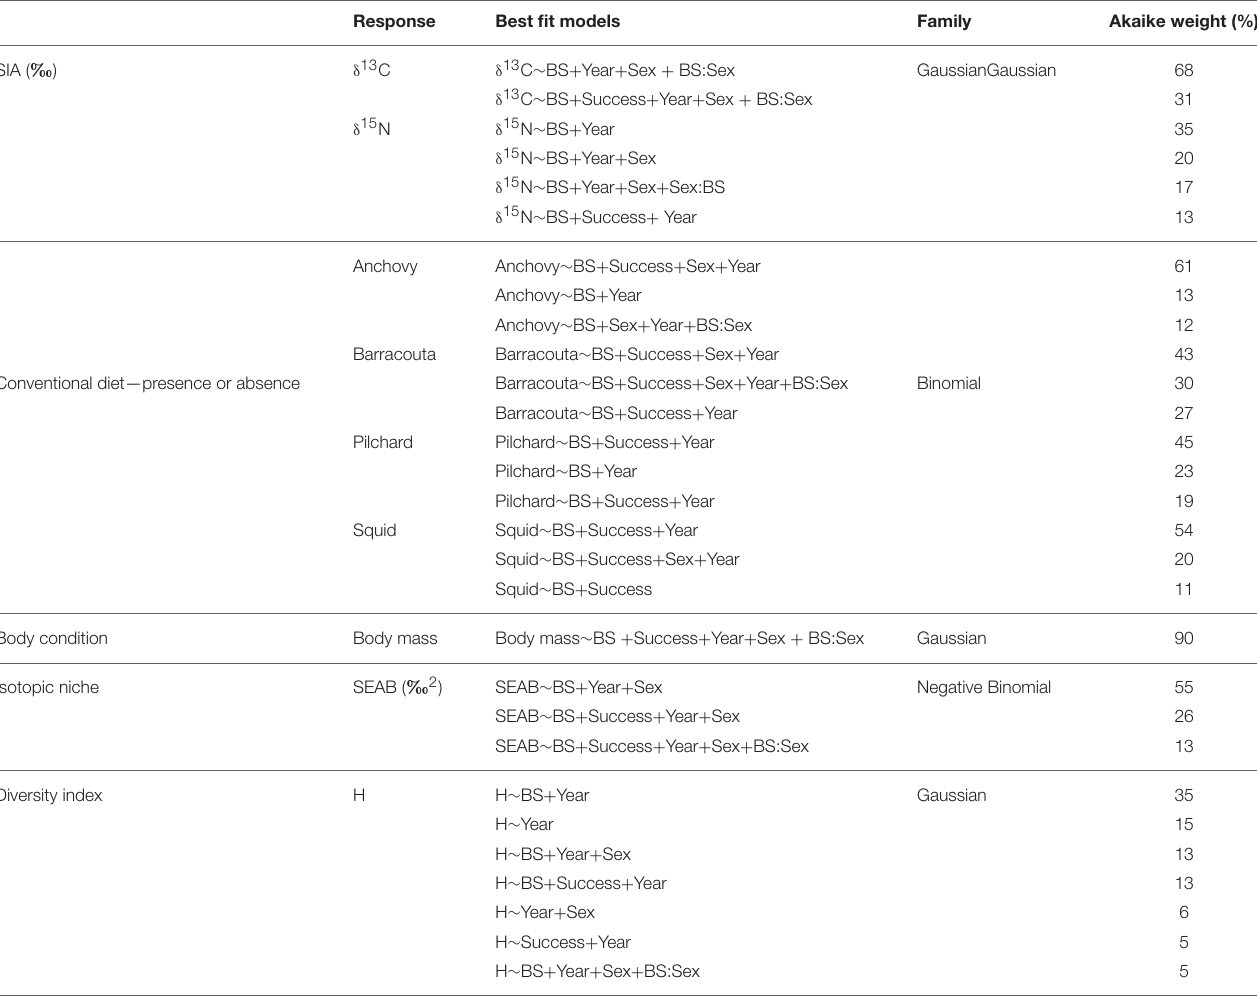
TABLE 2 | Model selection using response variables from stable isotope analysis ( δ 13 C, δ 15 N), conventional diet from stomach contents, body condition, isotopic niche analysis, and diversity